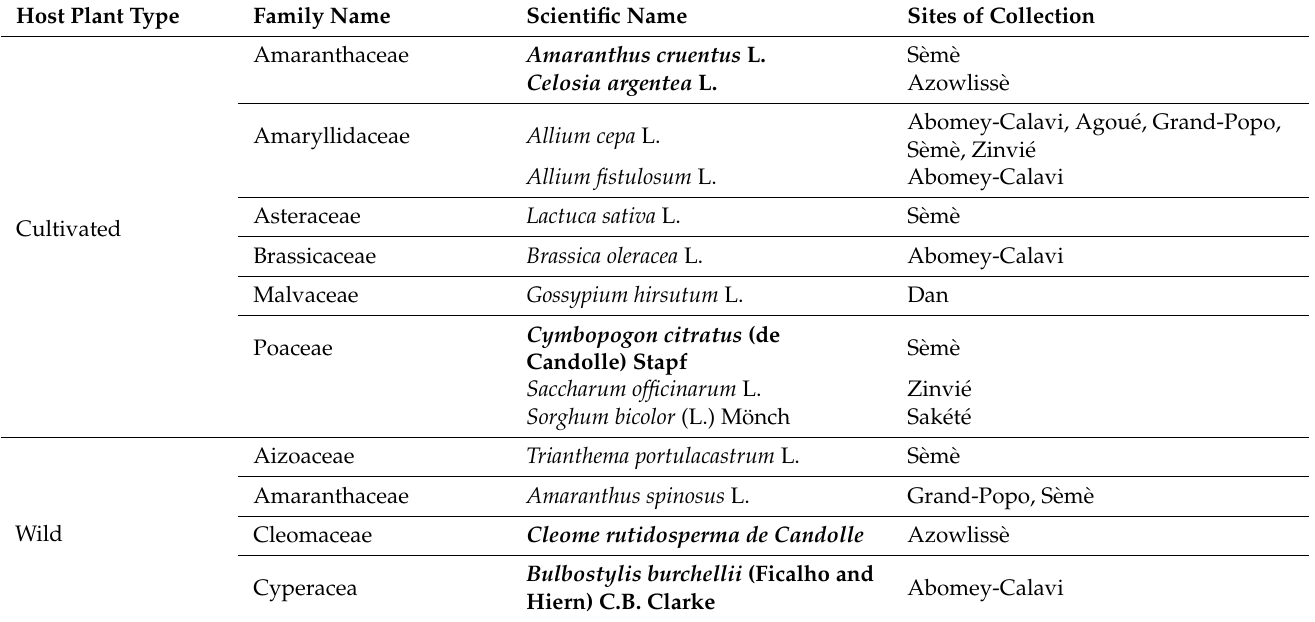
Table 1. FAW host plant species recorded in southern and central Benin. The eleven new host plant species records are in